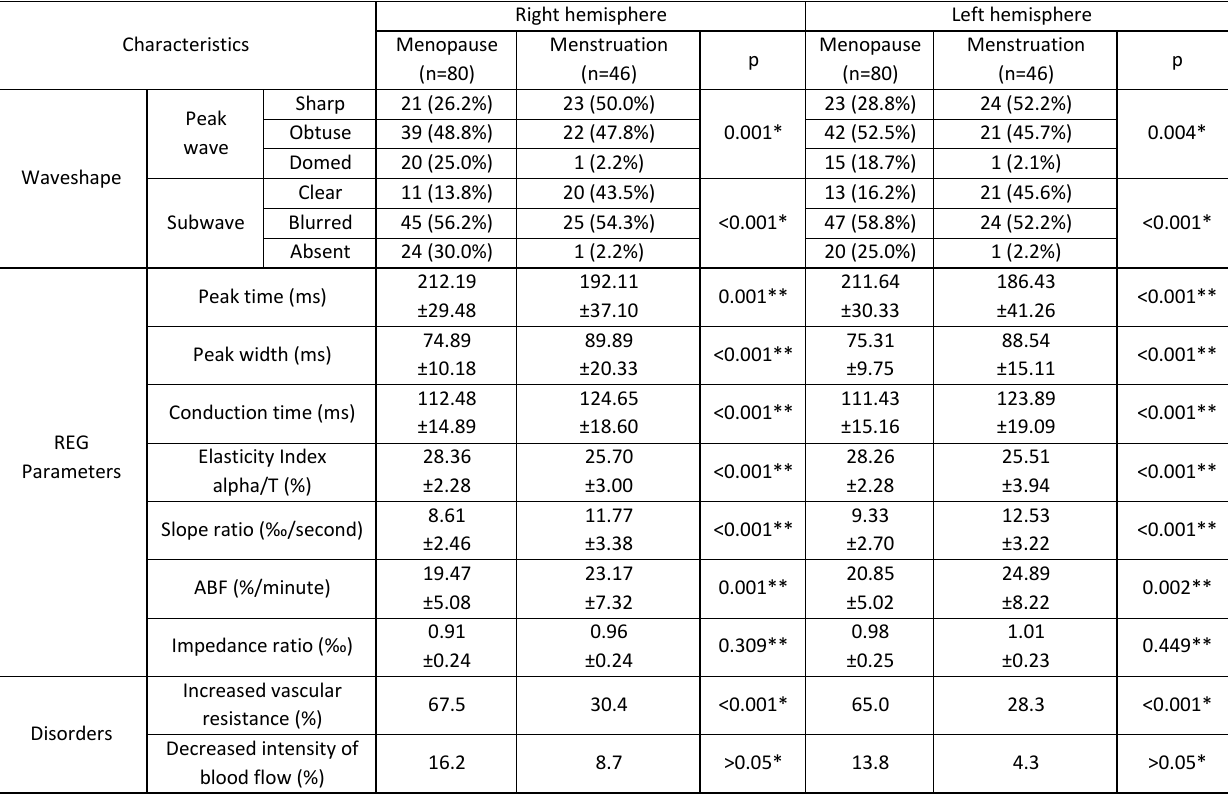
Table 2. Characteristics of REG in each hemisphere of the brain in the group of menopausal and menstruating women Right hemisphere Left hemisphere Characteristics Menopause